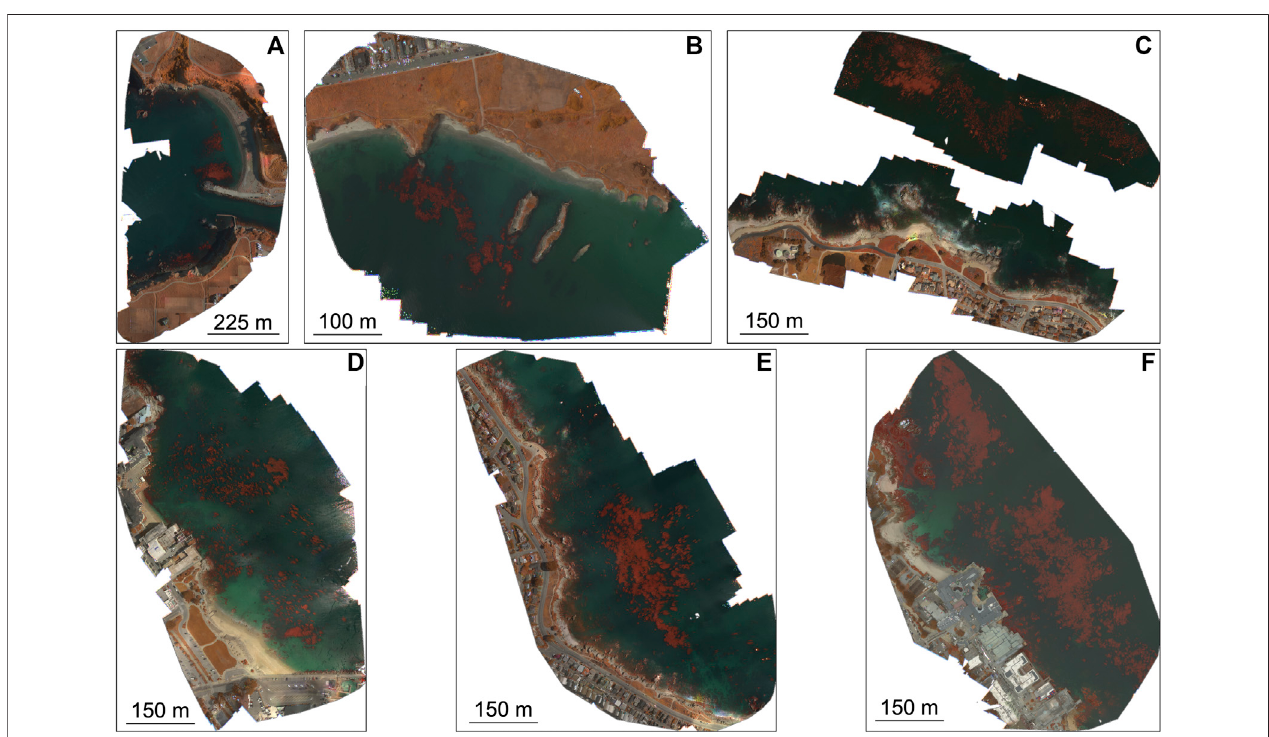
FIGURE 2 | Micasense RedEdge-M false color orthomosaics of the six survey sites. (A) Noyo Harbor (NH), Mendocino County; (B) Portuguese Beach (PB), MendocinoPeninsula; (C) PointPiños(PP),MontereyPeninsula; (D) OtterCove(OC),MontereyPeninsula; (E) SanCarlosBeach(SCB),MontereyPeninsula; (F) Hopkins Marine Station (HMS), Monterey Peninsula.